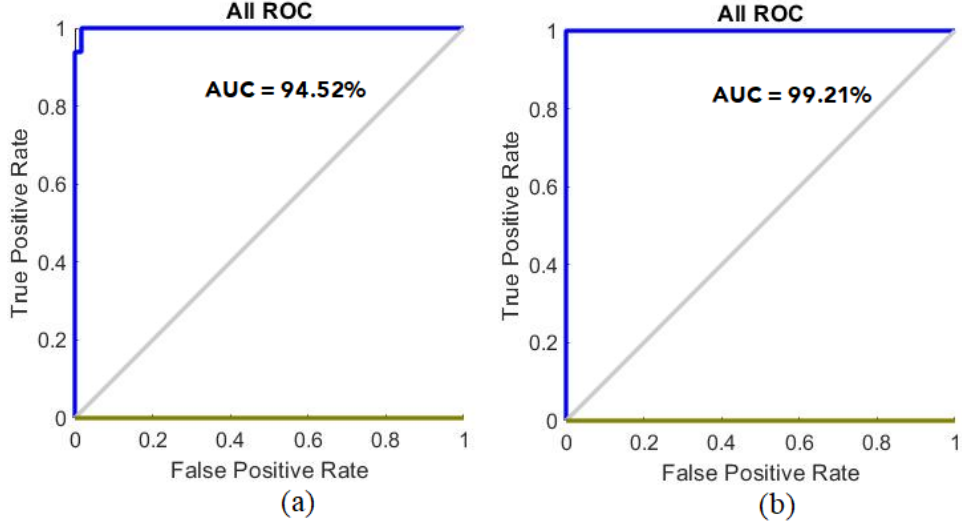
Figure 15. Receiver operating characteristic values of the ( a ) ALL_IDB1 and ( b ) ALL_IDB2 datasets.